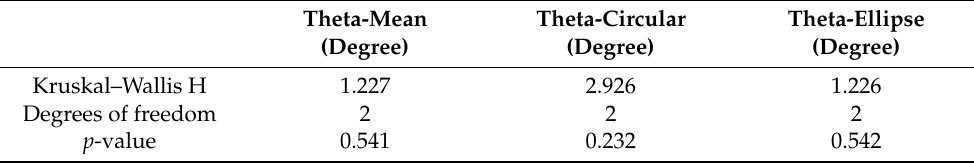
Table 5. Statistical analysis of theta-mean, theta-circular, and theta-ellipse values.